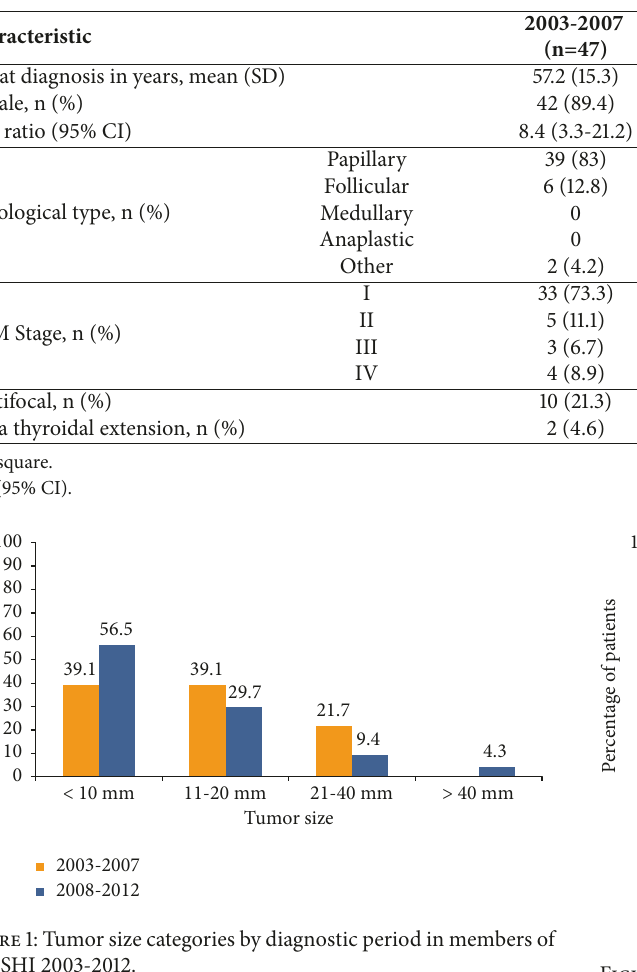
Table 2: Patient and tumor characteristics of incident cases of thyroid cancer in PSHI (2003-2012).